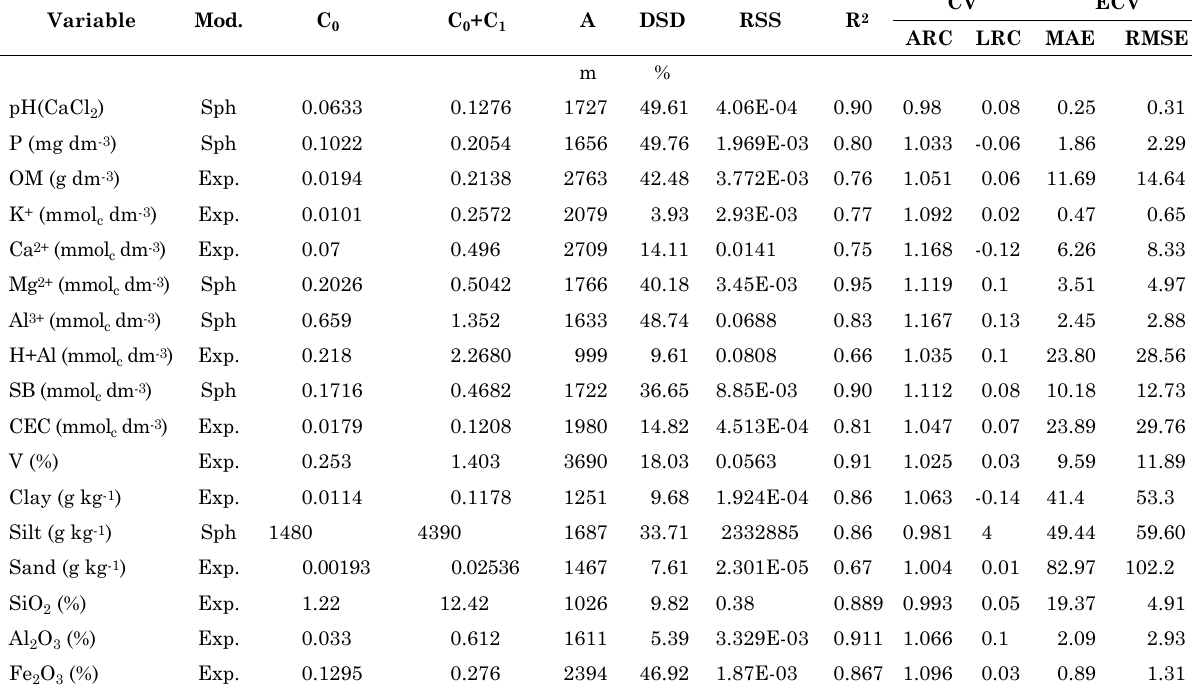
Table 2. Models, parameters of the semivariograms, and coefficients of cross and external validation of the chemical and particle size variables studied in the agrarian reform settlement